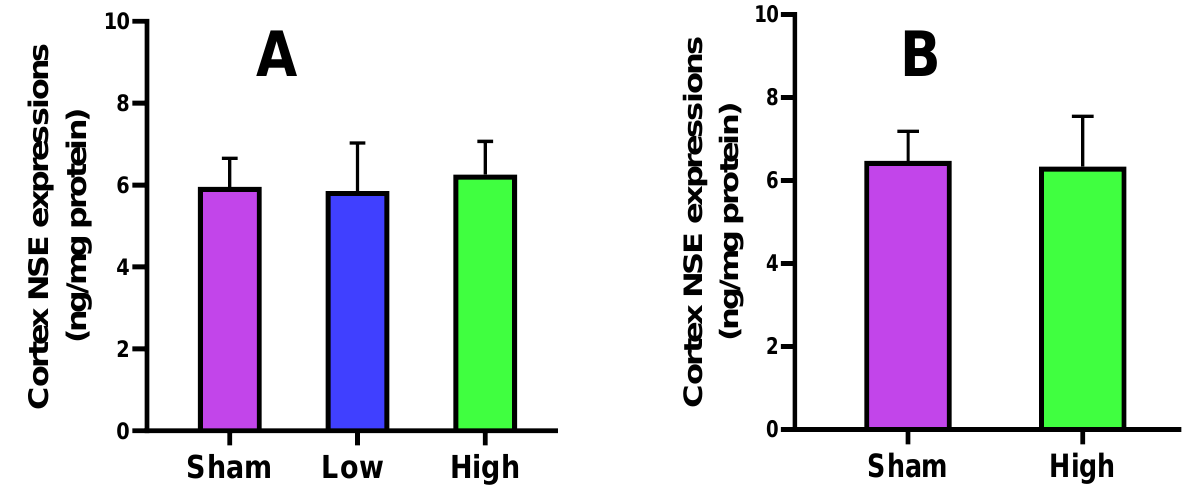
Figure 4. Effect of tDCS-iTBS on cortex NSE expressions (ng/mg protein): ( A ) short-term ( n = 15) and ( B ) long-term stimulations ( n = 16).